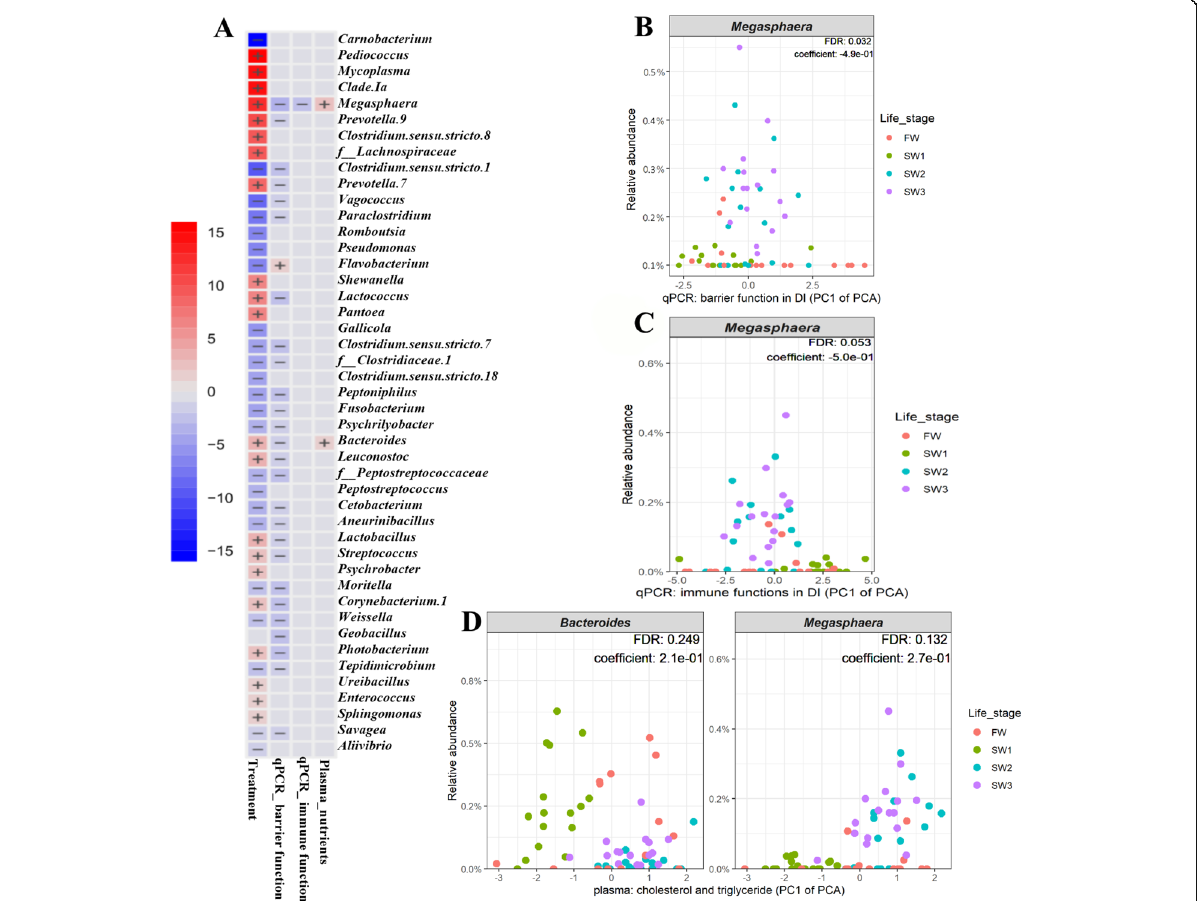
Fig. 5 Significant associations between microbial clades with sample metadata. a Heatmap summarizing all the significant associations between microbial clades and sample metadata. Color key: -log (q-value) * sign (coefficient). Cells denoting significant associations are colored (red or blue) and overlaid with a plus (+) or minus ( − ) sign indicating the direction of association: qPCR_barrier_function ( − ), negative correlation between microbial clade abundance and qPCR_barrier_function (PC1 of PCA); qPCR_immune_response ( − ), negative correlation between microbial clade abundance and qPCR_immune_function (PC1 of PCA); plasma_nutrients (+), positive correlation between microbial clade abundance and the levels of plasma_nutrients (PC1 of PCA). b The negative correlation between the relative abundance of Megasphaera and qPCR_barrier_function (PC1 of PCA). c The negative correlation between the relative abundance of Megasphaera and qPCR_barrier_function (PC1 of PCA). Of note, the gut immune gene expression levels were negatively correlated with PC1 of the PCA, which decreased as PC1 of the PCA increased (Additional file 3: Table S2). Hence, the relative abundance of Megasphaera shows a positive correlation with immune gene expression level. d The positive correlation between the relative abundance of Megasphaera and Bacteoides and plasma_nutrients (PC1 of PCA), respectively. FDR, false discovery rate; f__, family. The significant association was set at